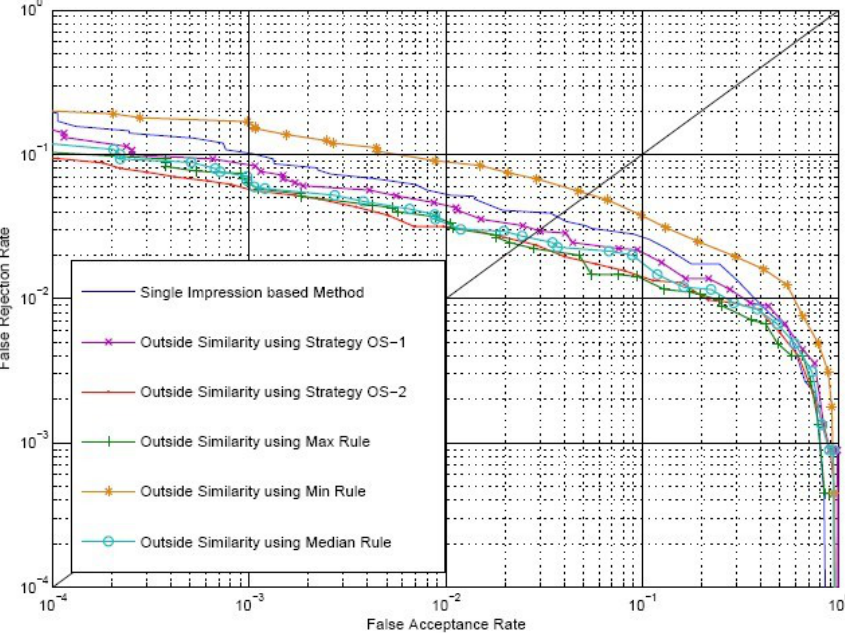
Figure 9. Receiver operating curves (ROC) of S R and S O .